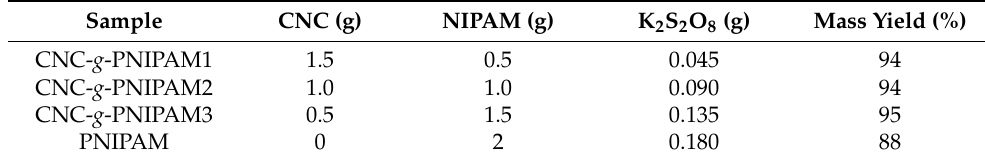
Table 3. Amounts of reactants used to prepare the CNC- g -PNIPAM copolymers and PNIPAM.